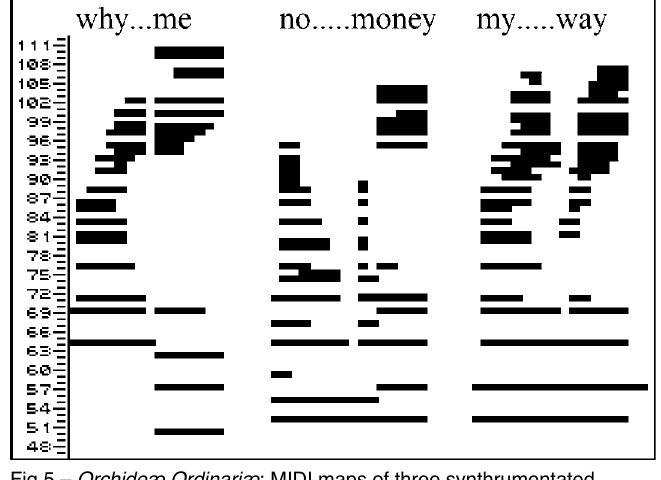
Fig.5 – Orchideæ Ordinariæ : MIDI maps of three synthrumentated phrases in